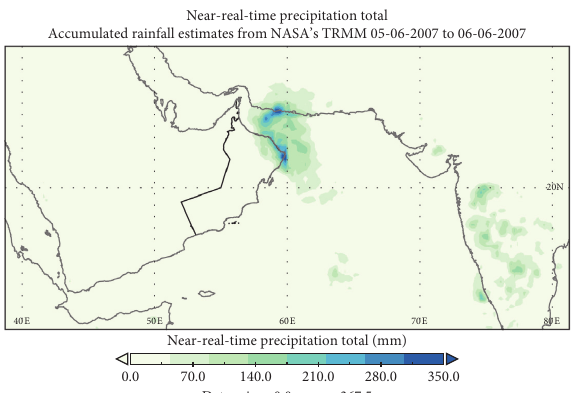
Figure 8: Near real-time daily accumulated rainfall estimates from NASA’s TRMM satellite (0.25 degree) for 2 days (5-6) June 2007.